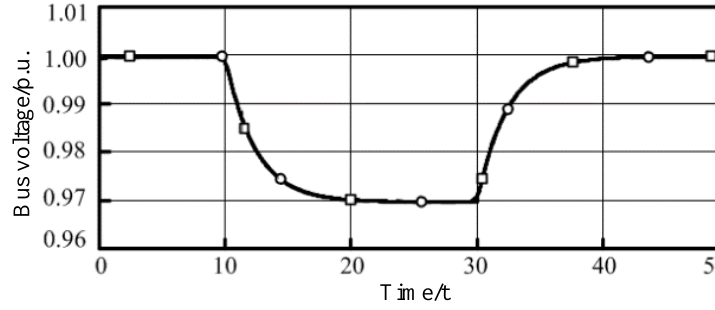
Figure 12. Bus voltage curve.